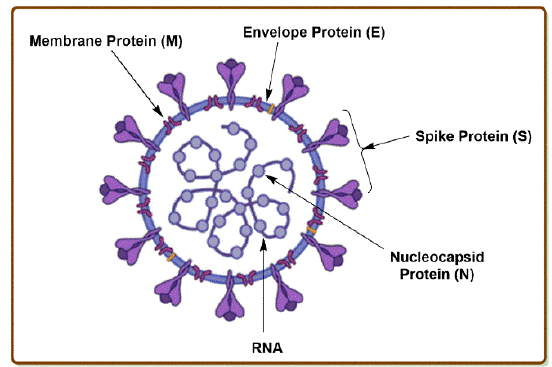
Figure 2: The structure of coronavirus